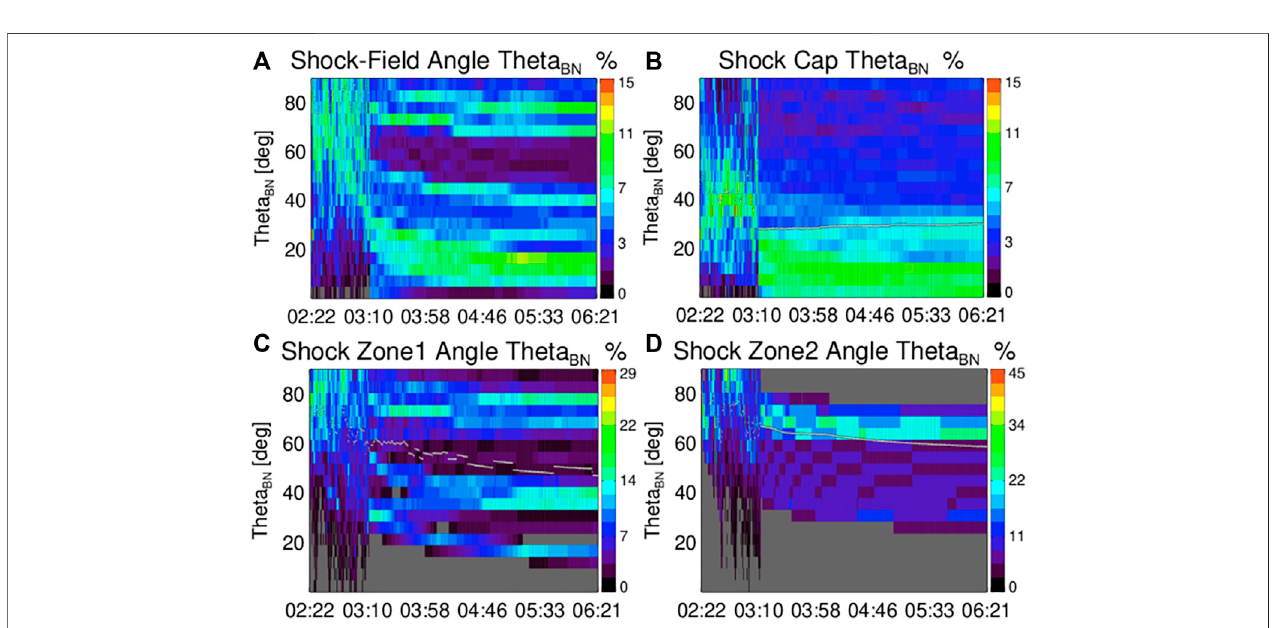
FIGURE6| Dynamic spectrashowingthedistributionsofthe θ BN shock- fi eldangleasafunctionoftime for theMay 11,2011event.The (A) shows thedistribution over time for the entire S2M surface. The (B – D) plots show the distributions for the S2M points of the cap, zone 1, and zone 2, shown in Figure 2 with blue, green, and red, respectively. The white dot symbols show the mean at each time